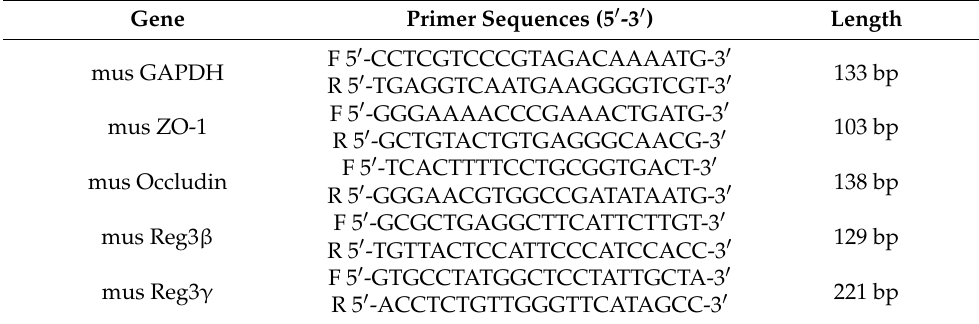
Table 2. Primer sequences used for qRT-PCR